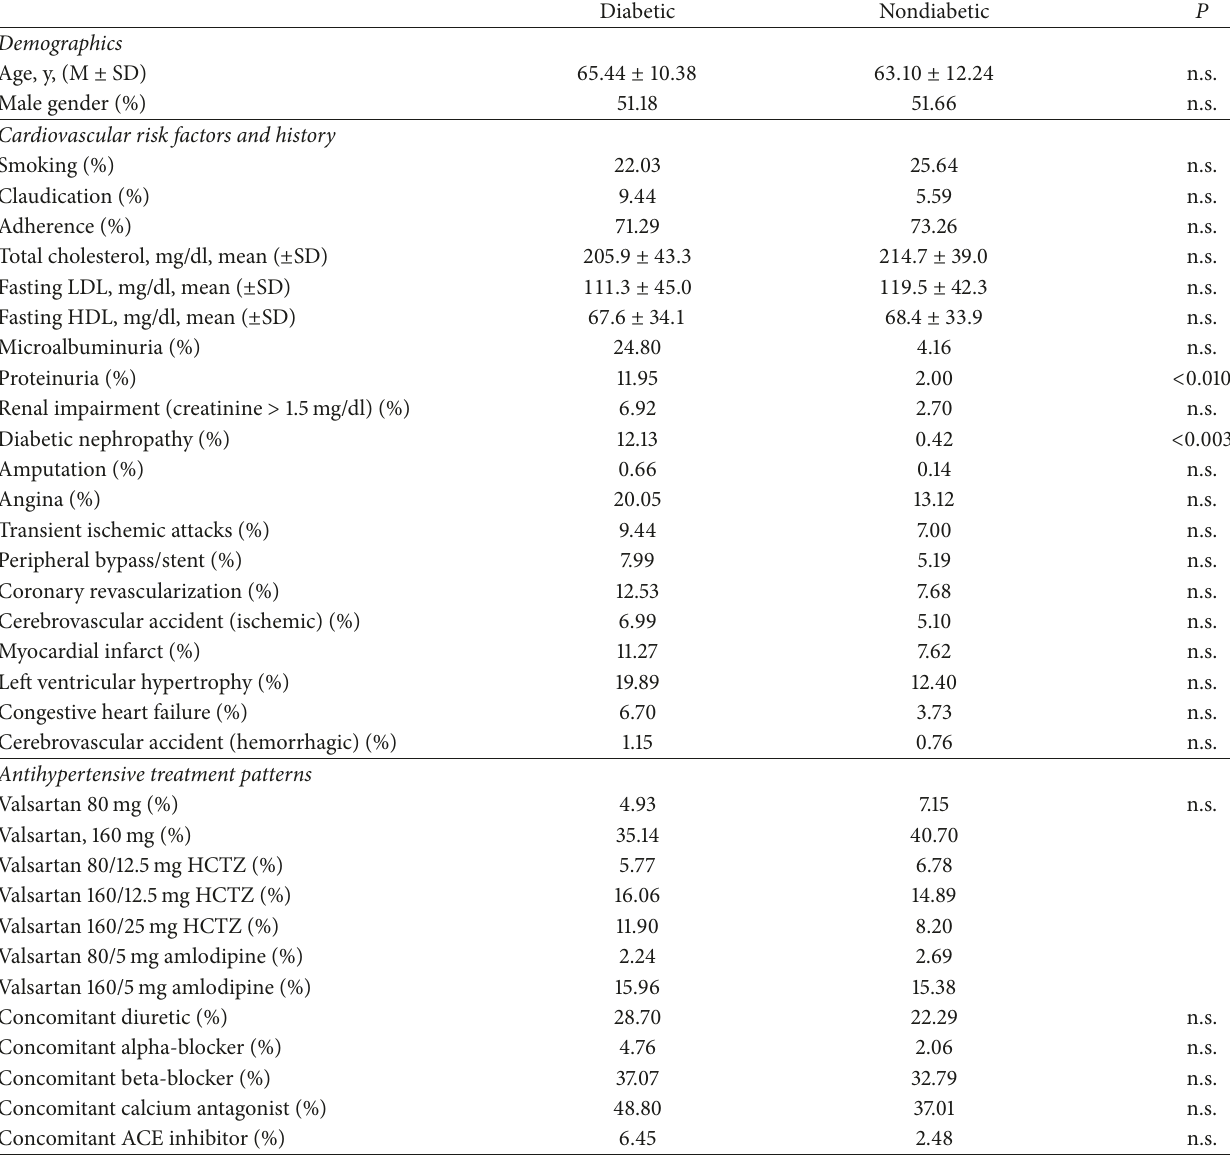
Table 2: Patient characteristics by diabetes status. Diabetic